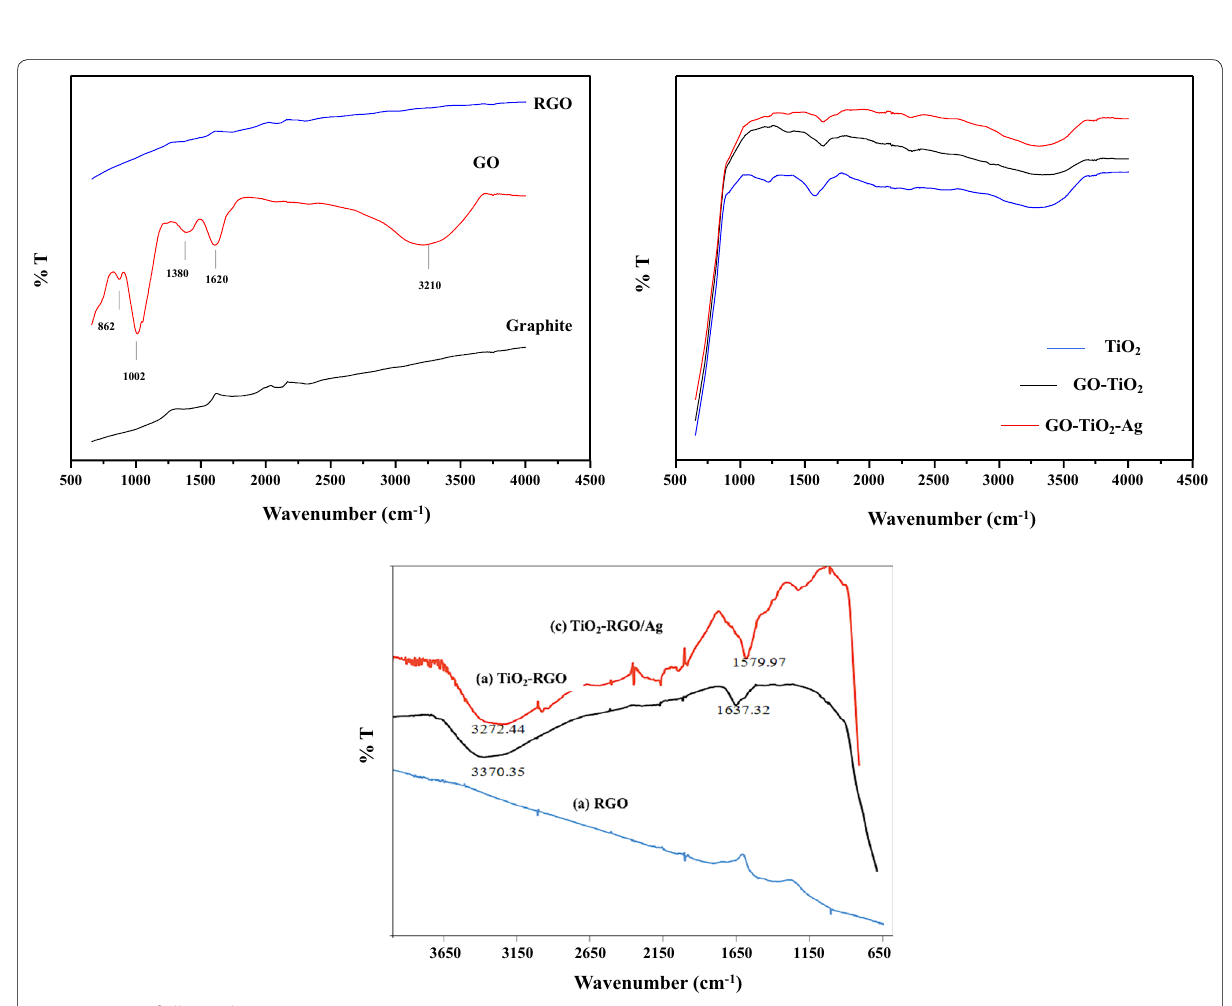
Fig. 5 ATR-IR of all